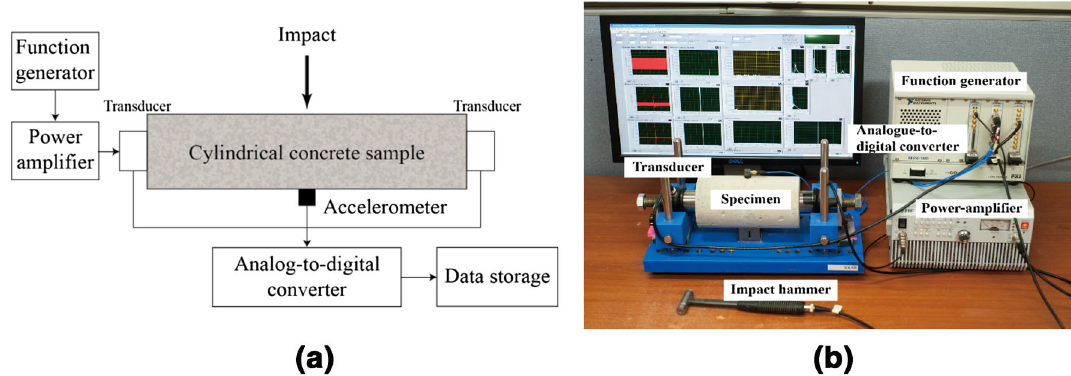
Fig. 3 Experimental setup of nonlinear modulation method. a Schematic of experimental system and b experimental